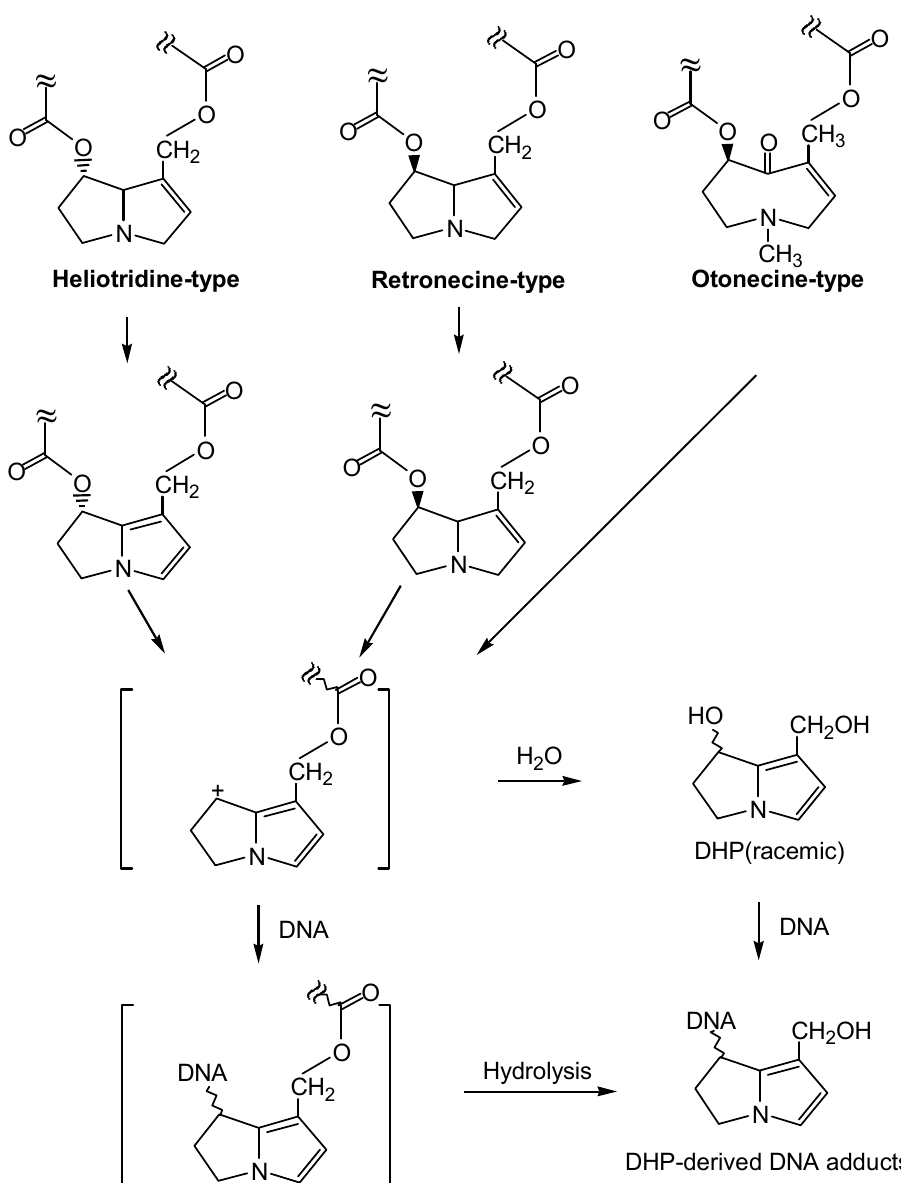
Figure 6. A proposed general mechanism leading to an identical set of DHP-derived DNA adduct formation from metabolism of the three major classes of carcinogenic pyrrolizidine